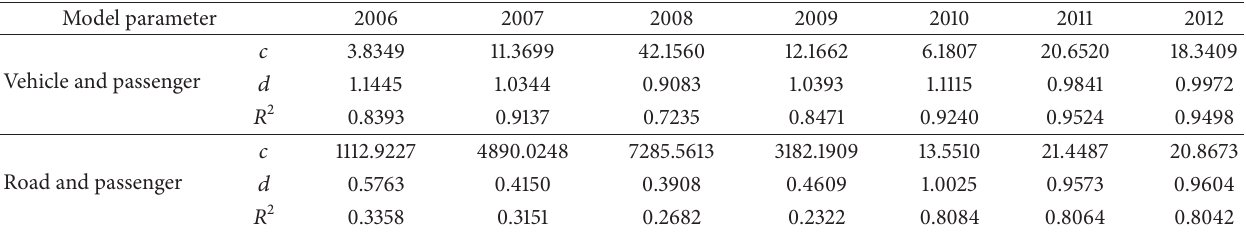
Table 5: Parameters and statistics of allometric models on public transportation of China’s cities (2006–2012). Model parameter